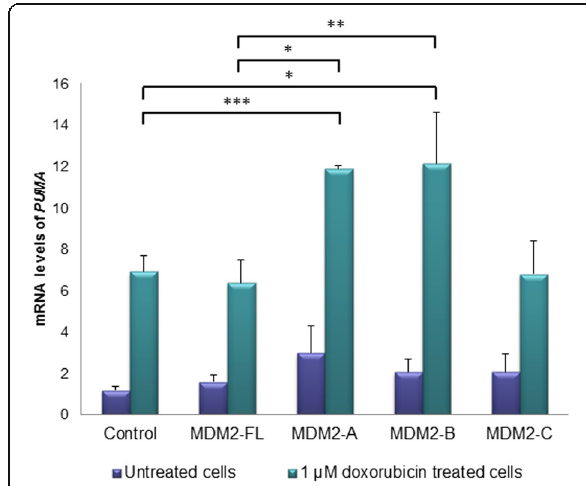
Fig. 4 Expression of PUMA upon overexpression of the MDM2 splice variants. Activation of PUMA after transfection with the splice variants by qPCR assay revealing relative mRNA levels of PUMA . MCF-7 cells transfected with pCMV-GFP (GFP-control), MDM2-A, -B and -C, sorted after 12 h based on GFP expression. Graphs show the untreated cells ( purple bars ) and the 24 h 1 μ M doxorubicin ( green bars ). The experiment was repeated in triplicate, with three independent transfections. *= p ≤ 0.05, **= p ≤ 0.01, ***= p ≤ 0.001